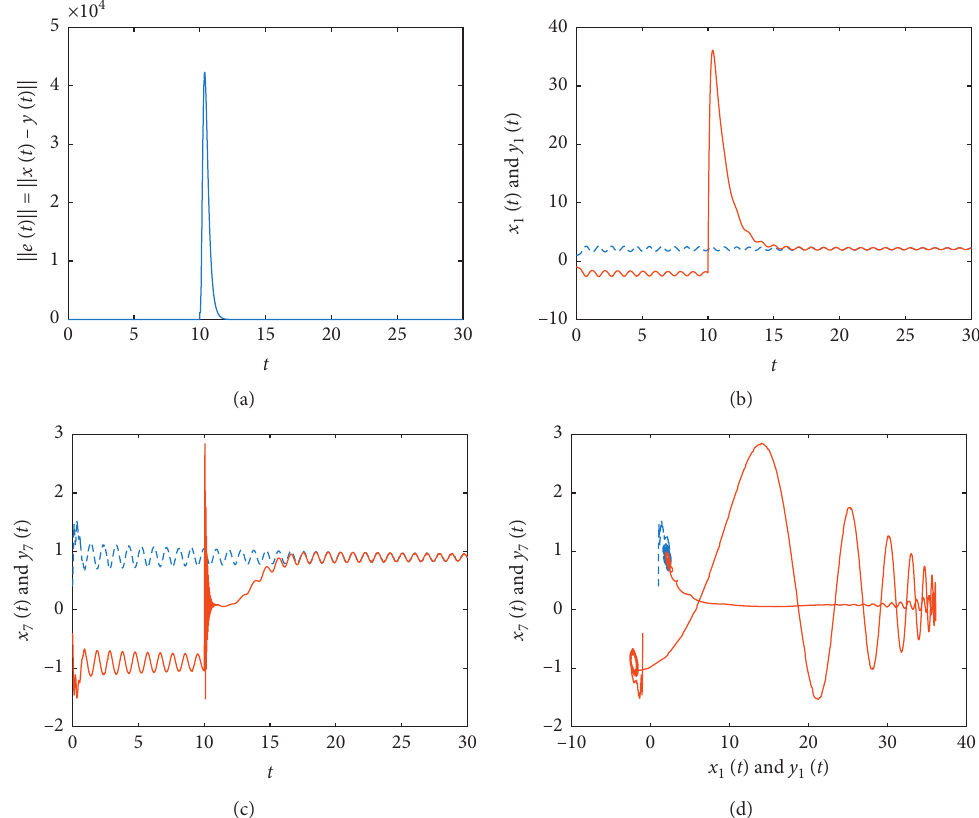
� 20 in the slave system (8) to a e ( t ) and y ( t ) versus time. (d) The states x 7 7